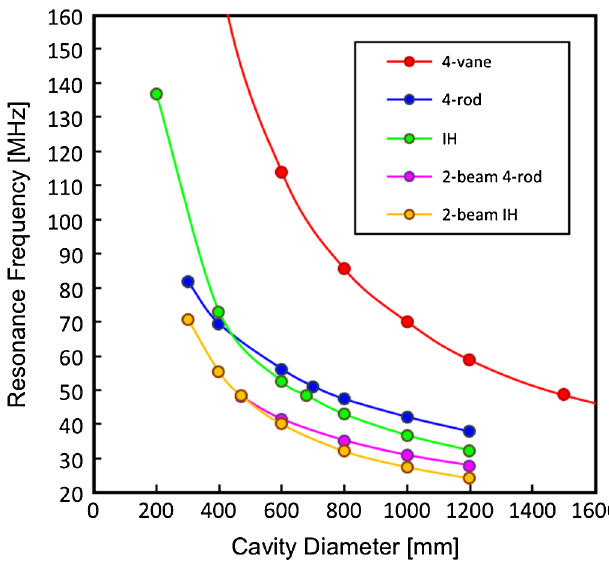
FIG. 18. Resonance frequency as a function of the cavity diameter of the RFQ linacs. The length of the cavities is 1.5 m.